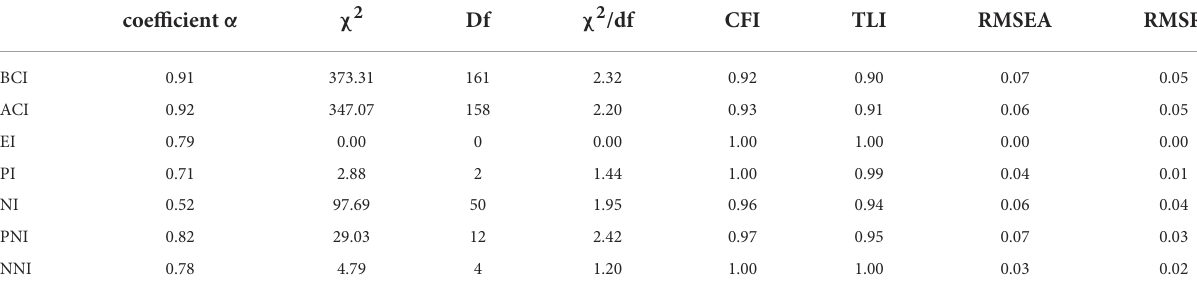
TABLE 2 The results of coefficient α and indicators of CFA in subscales.